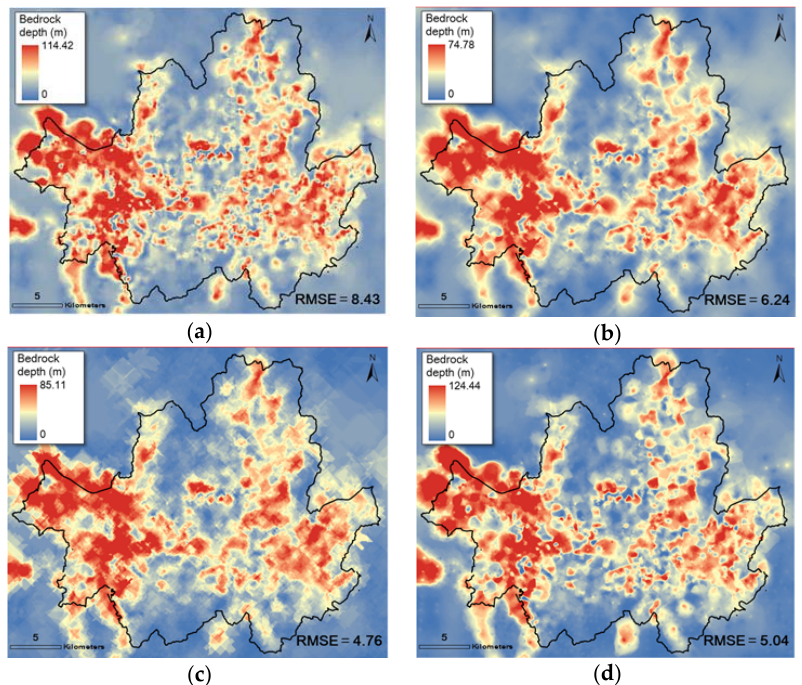
Figure 5. Spatial distribution of bedrock depth in Seoul, determined using four representative geostatistical interpolation methods: ( a ) inverse distance weight ( b ) simple kriging ( c ) ordinary kriging and ( d ) empirical Bayesian kriging.